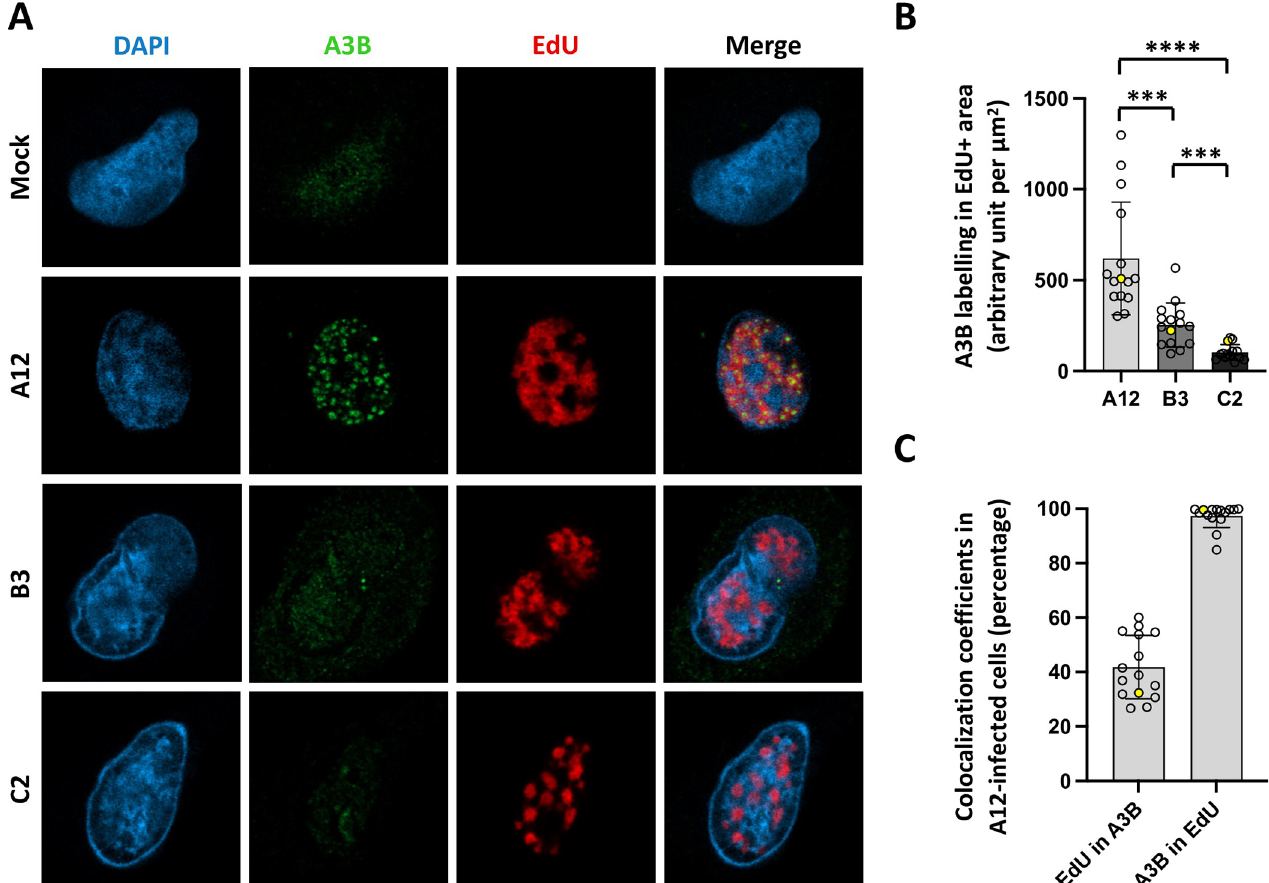
Fig 8. A3B recolocalizes inside the viral replication centers in A12-infected cells. A549 cells were infected with HAdV-A12, -B3, -C2 or mock control at a MOI = 3. B3- and C2-infected cells were analyzed 20 hours post infection and A12-infected cells were analyzed 24 hours post infection. (A) The A3B protein (green) and the viral replication centers as identified by EdU labelling (red) were imaged by fluorescence microscopy. (B) A3B labelling was quantified within the EdU+ area. Each circle represents a given cell. The yellow-colored circles correspond to the images shown in panel A. P-values were calculated by unpaired t-tests. (C) Colocalization between A3B and EdU labeling in A12-infected cells was estimated using Manders’